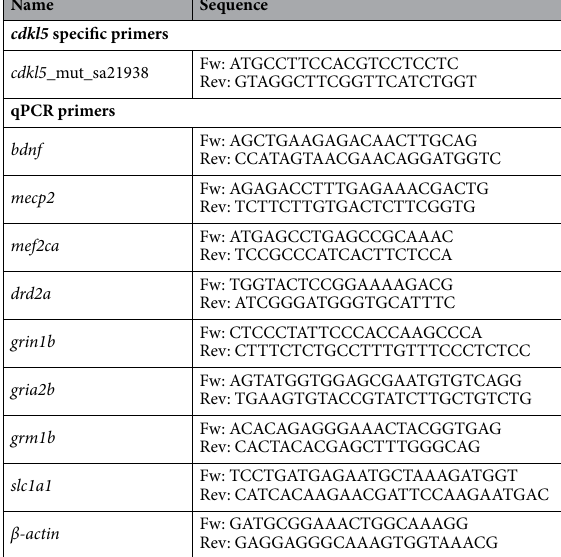
operators. All efforts were made to minimize pain, distress, and discomfort. Experiments were terminated (fish were returned to normal conditions or euthanized) whenever adverse effects were observed. Fish maintenance. Mutant cdkl5 sa21938 zebrafish line generated by Stemple lab 41 was obtained from EZRC. Adult wild-type (WT) zebrafish (AB strain) and cdkl5 sa21938 mutant zebrafish were maintained in a recirculating system at controlled room temperature (28 °C) and kept under a 14 h light -10 h dark cycle. For the reproduc- tions, adult females were separated from males with plastic dividers in breeding boxes the night before spawn- ing. The next day, they were allowed to spawn naturally. The embryos were raised in E3 medium with 0.1% methylene blue to avoid fungal contamination and staged according to the morphological scheme described by Kimmel et al. 42 . Dead or undeveloped embryos were removed daily. For the experiments using the cdkl5 sa21938 mutant line, heterozygous embryos were obtained by crossing adults F3 homozygous mutants with AB wild-type zebrafish; homozygous embryos were obtained by incross adults F3 homozygous mutants, and AB wild-type zebrafish was used as control. Genotyping of cdkl5 sa21938 zebrafish mutants. To extract genomic DNA (gDNA), adult zebrafish were anesthetized in tricaine methanesulfonate (MS222) solution (168 mg/L), and the tail fin was clipped and incu- bated at 95 °C in 25 μl alkaline lysis buffer containing 25 mM NaOH and 0.2 mM EDTA. After dissolution, 25 μl of neutralization buffer (40 mM Tris–HCl. pH = 8) was added. Then, the cdkl5 fragment flanking the mutation was amplified by polymerase chain reaction (PCR) from 50 ng of gDNA using specific primers (Table 1) and Taq DNA polymerase (Invitrogen) following manufacturer instructions. PCR conditions were as follows: initial denaturation step at 94 °C for 3 min; 35 cycles of amplification (denaturation at 94 °C for 30 s; annealing at 57 °C for 30 s; extension at 72 °C for 15 s); and a final extension at 72 °C for 10 min. PCR products were separated in an agarose gel (1.2%) by electrophoresis, then visualized under ultraviolet light using Safe Green nucleic acid stain (Nzytech) and sequenced (CCMAR). Morphometric analysis of cdkl5 mutant line. Phenotype of zebrafish cdkl5 mutants was visualized and photographed at different developmental stages using a Leica MZ10F stereomicroscope. Parameters including body length, head length and head width were measured using ImageJ software. Alcian blue-Alizarin red double staining. Zebrafish with 5 dpf and 14 dpf were collected and sacrificed with a lethal dose of anesthesia (MS222). After washing twice with phosphate-buffered saline (PBS), zebrafish were fixed overnight in 4% paraformaldehyde (PFA; Sigma). They were washed twice with PBS and dehydrated in increasing ethanol series. Acid-free double staining was performed following Walker and Kimmel protocol 43 . Briefly, zebrafish were incubated with double stain solution (0.02% Alcian blue, 40 mM MgCl 2 , 0,005% Alizarin red S) overnight at room temperature under agitation. The pigmentation was removed by exposing the zebrafish to a bleaching solution of 1.5% H 2 O 2 and 1% KOH for 20 min. Then, the tissue was cleared using successive changes of glycerol and KOH solution. Stained zebrafish were visualized and imaged using a stereomicroscope (Leica MZ10F). Several craniofacial parameters, such as ceratohyal angle (Ch-a), ceratohyal length (Ch-l), pala- toquadrate length (Pq-l), ceratohyal cartilage length (CCL) and lower jaw length (LJL) were measured using Image J.